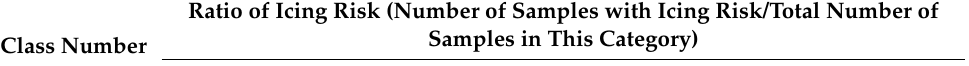
Table 6. Risk proportion of each type of sample icing.